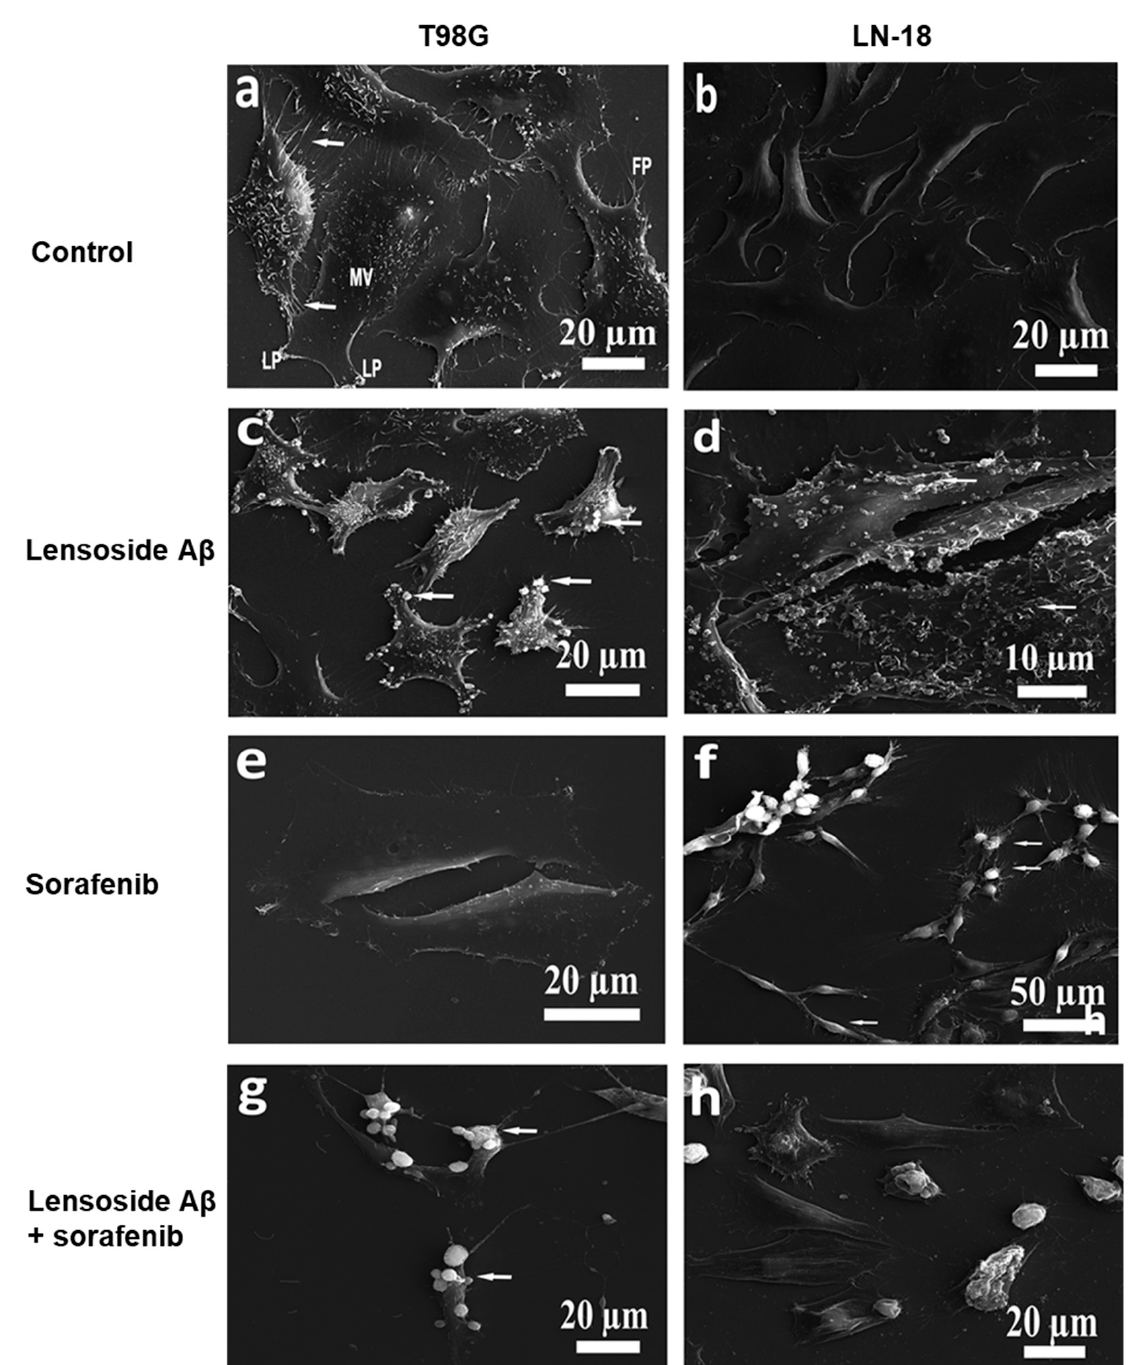
Figure 10. Characteristics of the surface phenotypes of the control T98G and LN-18 cells ( a , b ) and cells treated with lensoside A β ( c , d ), sorafenib alone ( e , f ), and with a combination of both drugs ( g , h ). ( a ) Electron micrograph of the T98G cells showing lamellipodia (LP), filopodia (FP), microvilli (MV), and long, thin, parallel projections (arrows) connecting adjacent cells. ( b ) Adherent and polygonal-shaped LN-18 cells. ( c ) Electron micrograph showing many microvesicles on the edges of T98G cells incubated with lensoside A β (arrows). ( d ) LN-18 cells with ruffles and blebs on the surface. ( e ) Visible loss of interconnections and microvilli in T98G cells. ( f ) LN-18 cells with prominent bundles of thin processes and deformed bodies of cells. ( g ) T98G cells with lost microvilli; blebs are visible on the surface. ( h ) LN-18 cells with ruffles on the surface, deformed bodies, and globular-shaped bodies.